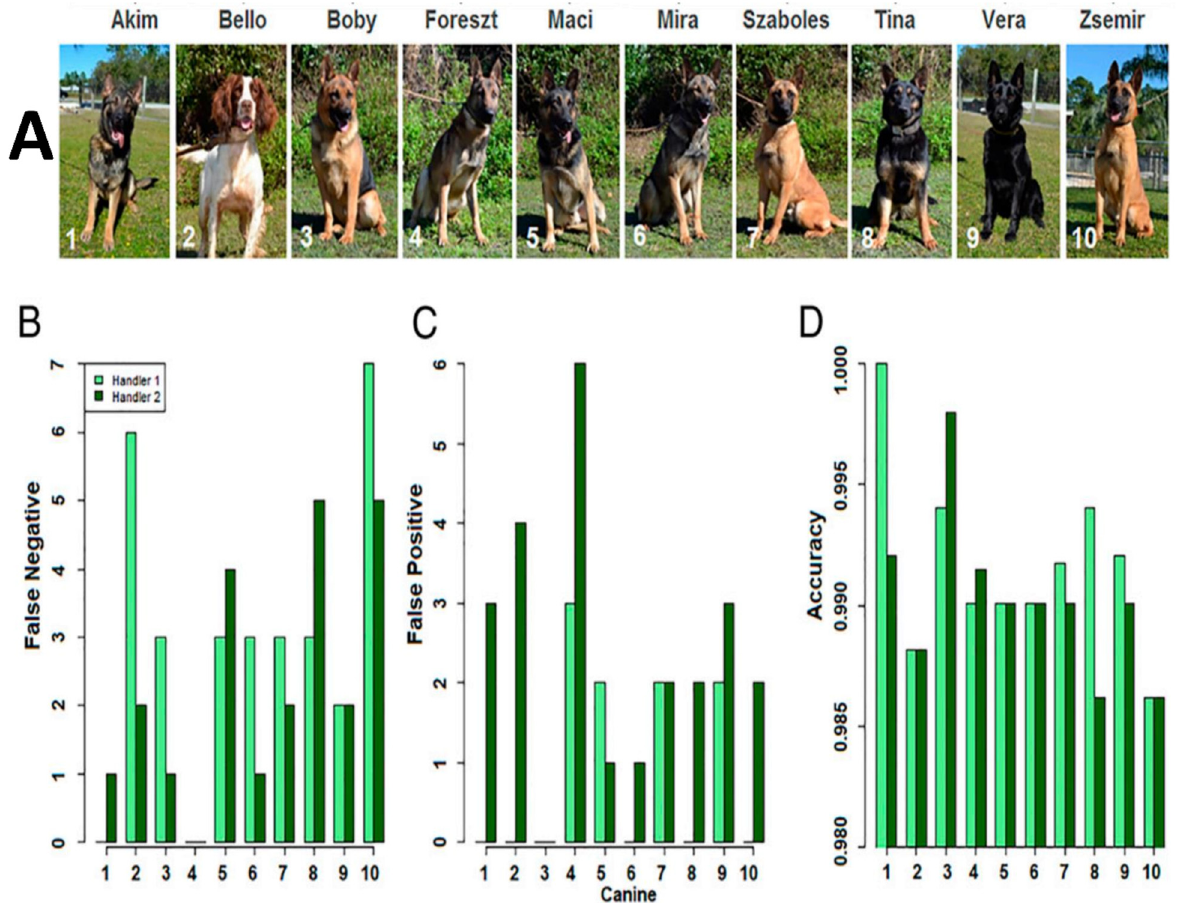
Figure 5. Canine performance for detecting C Las in citrus. ( A ) The canines with the fewest total errors were Akim, Boby, and Mira with four, six, and six errors, respectively. Caninehandler team performance assessment. ( B ) False negative error. ( C ) False positive error. ( D ) Overall accuracy